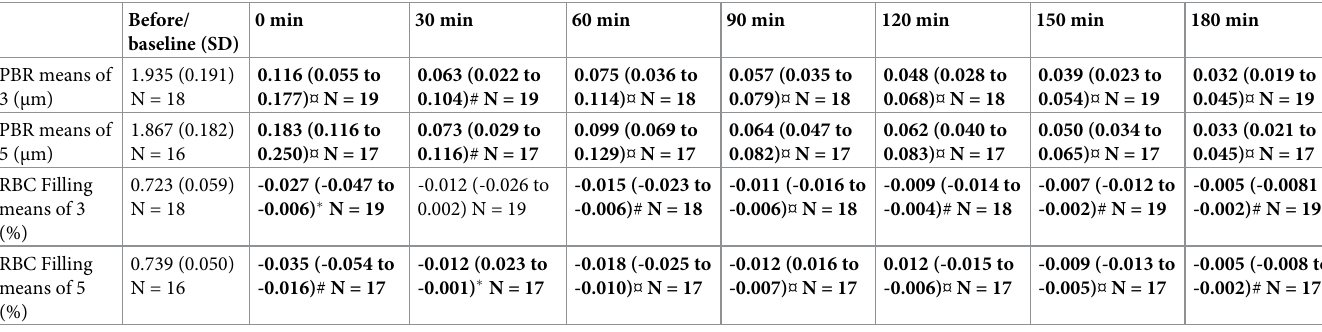
Table 5. Results of a high calorie meal before and at times 0–180 min. Before/ 0 min baseline (SD)